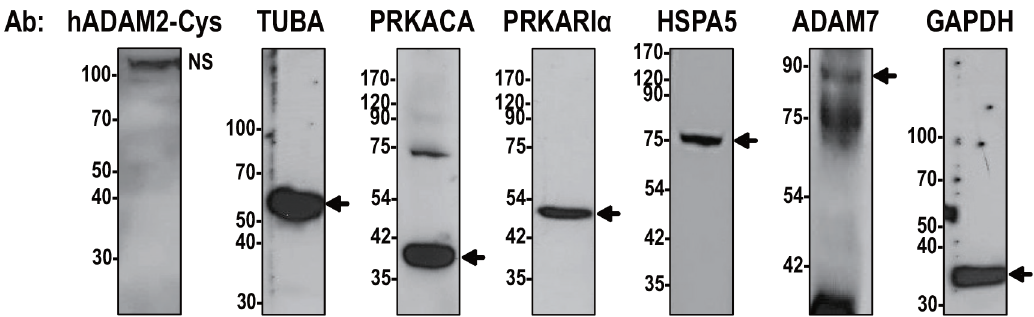
Fig 7. Integrity of human sperm proteins. Western blot analysis was performed using antibodies against ADAM2, PRKACA, PRKARI α , HSPA5, and ADAM7. The TUBA and GAPDH antibodies were used as controls. Experiments were repeated twice. Reduced protein samples were subjected to SDS-PAGE using 10% resolving gels. Abbreviation: NS, non-specific band. Molecular masses are presented on the